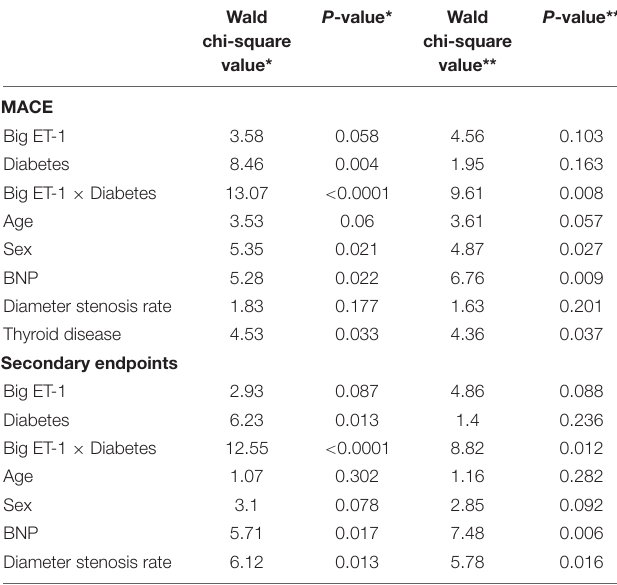
TABLE 3 | Interaction between big endothelin-1 and diabetes in the prognosis of MACEs and secondary end points. Wald chi-square